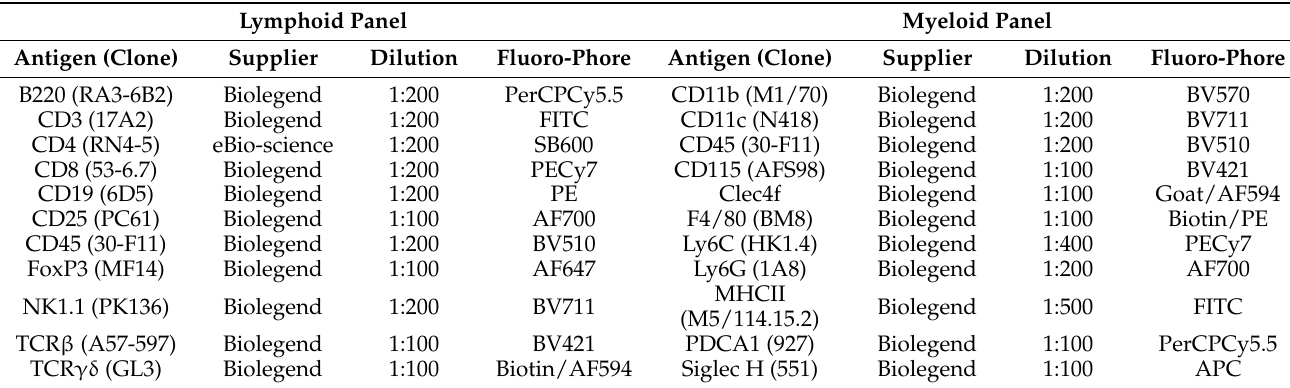
Table 2. Liver flow cytometry staining panel. Lymphoid Panel Myeloid